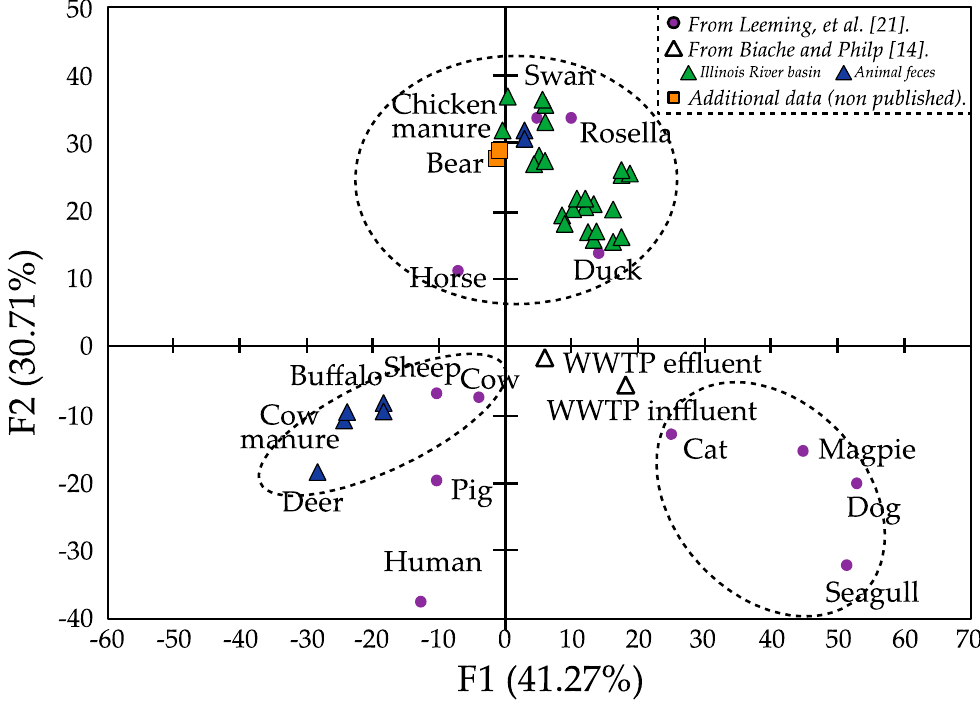
Figure 3. Plot of the principal component analysis of the Illinois River sediments with some feces samples (Adapted from Biache and Philp [14]). samples (Adapted from Biache and Philp